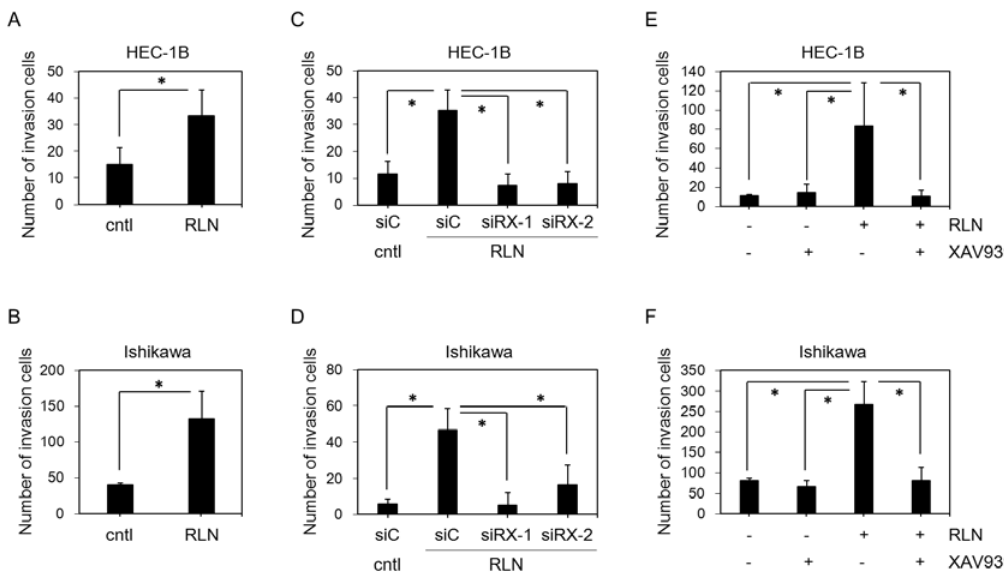
Figure 2. ( A , B ) The effect of relaxin 2 on the invasion of HEC-1B ( A ) and Ishikawa ( B ) cells. HEC-1B and Ishikawa cells were treated with RLN for 24 h. ( C , D ) The effect of down-regulated RXFP1 on invasion, which was induced by relaxin 2 treatment, in HEC-1B ( C ) and Ishikawa ( D ). ( E , F ) The effect of XAV939 on RLN induced-invasion of HEC-1B ( E ) and Ishikawa ( F ) cells. HEC-1B and Ishikawa cells treated with RLN alone or combined with XAV939 for 24 h. The data are expressed as means ± SD of three independent experiments with technical triplicates for each. *, p < 0.05 (Student’s t -test). cntl, vehicle control; RLN, relaxin 2; siC, control siRNA; siRX, RXFP1 siRNA.